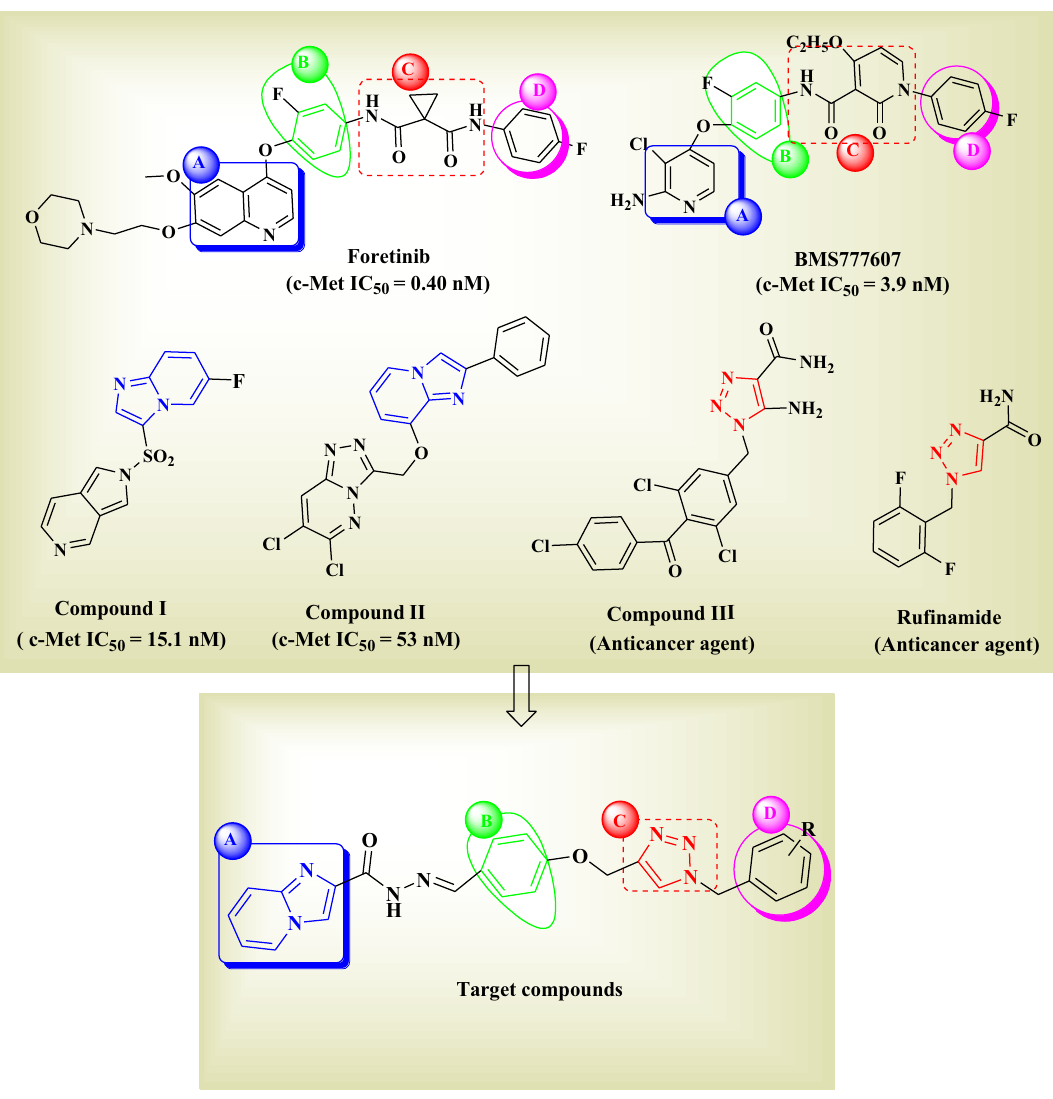
Figure 2. Strategy for the design of imidazo [1,2-α] pyridine derivatives bearing 1,2,3-triazole